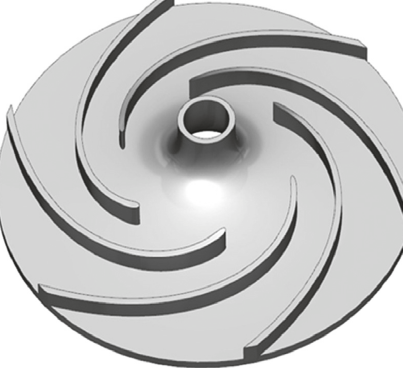
Figure 1: Impeller three-dimensional model. Table 2: Level table of orthogonal test